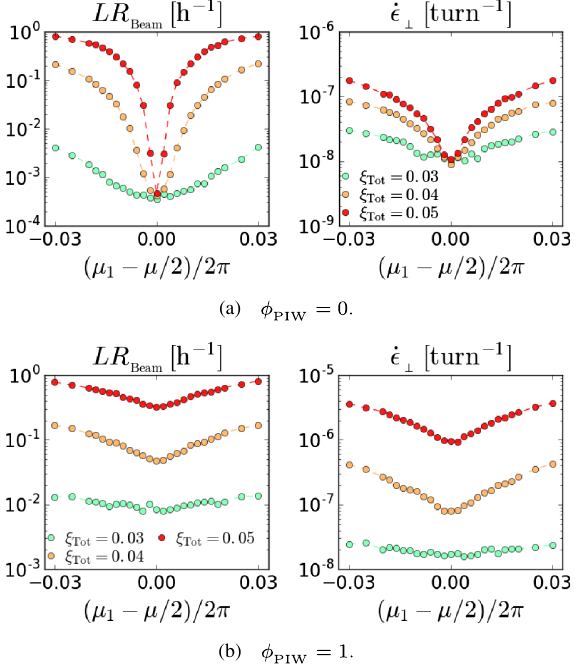
FIG. 14. Beam quality improvement for intermediate phase advance close to μ = 2 , for different values of ξ Q